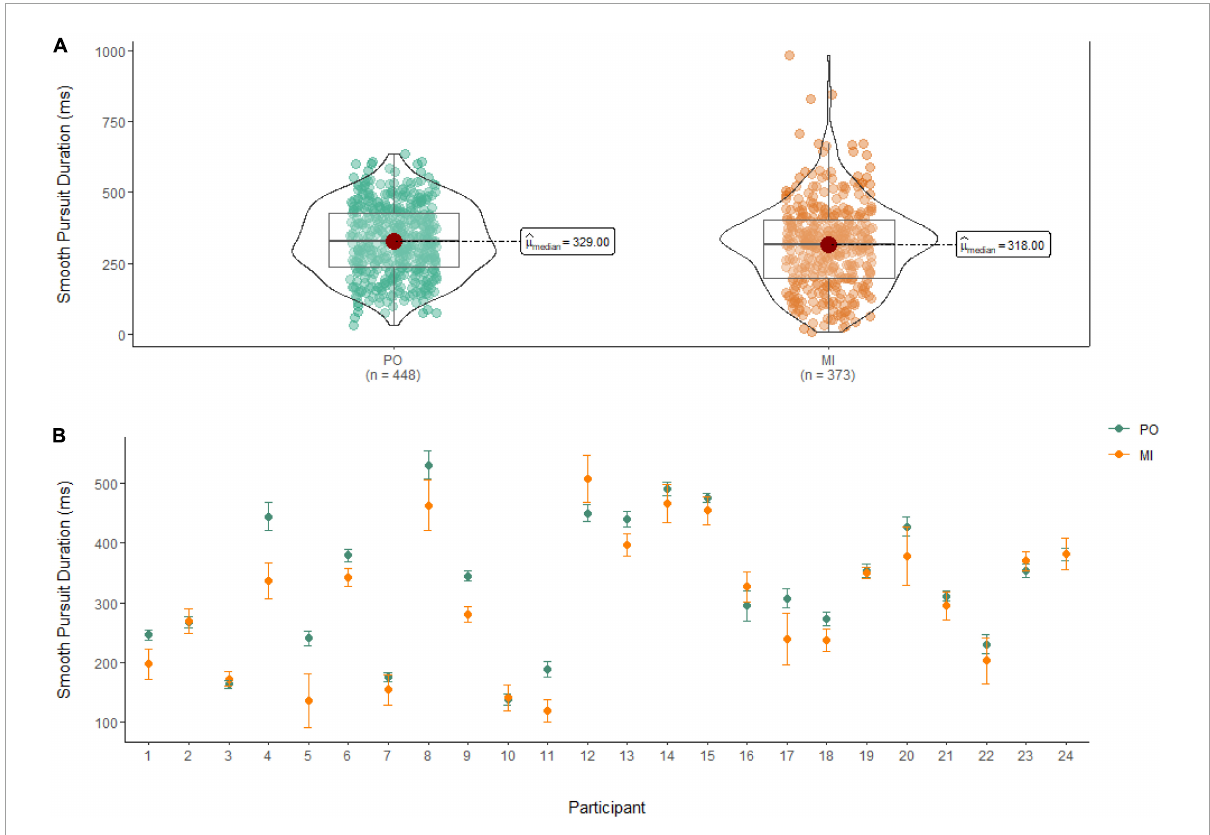
FIGURE4 (A) Smooth pursuit duration differences between PO (left) and MI (right). (B) The average duration of smooth pursuit for PO (blue) and MI (orange) is displayed for each of the 24 participants enrolled in the experiment. Error bars are standard error of the mean.